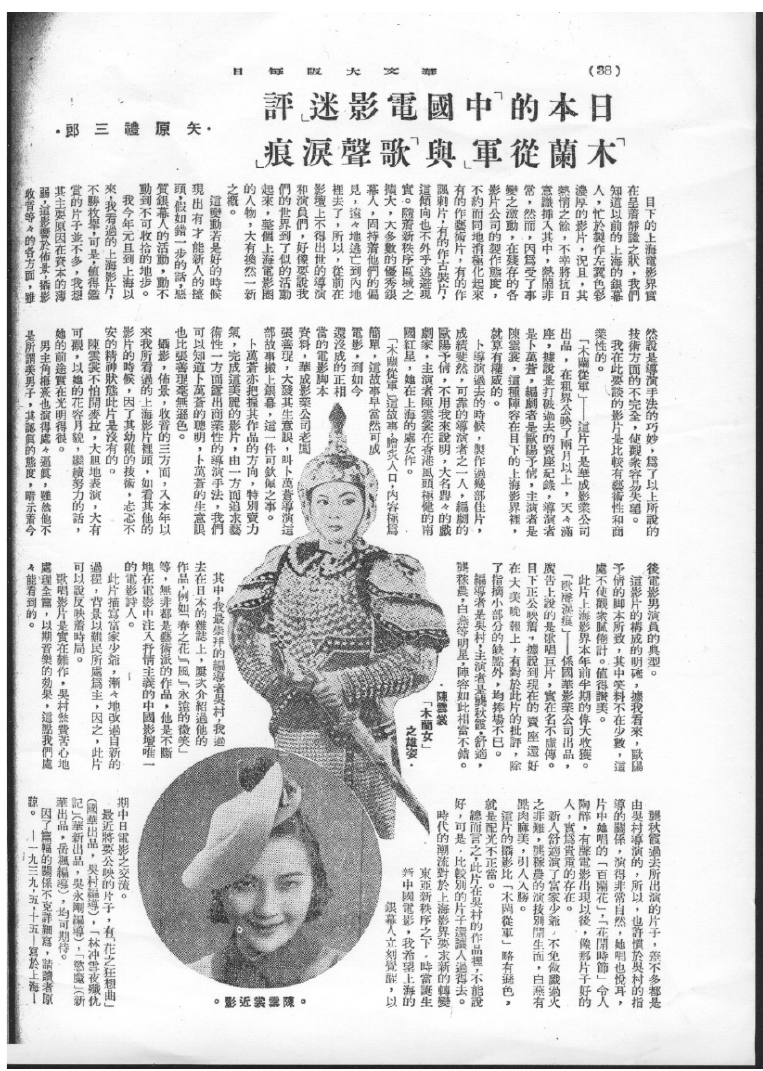
Figure 4. Yahara Reizaburou’s review of Mulan Joins the Army , published in Huawen daban meiri ( Osaka Daily in Chinese Language ) vol. 2, no. 11, 1939. Following the popular way at the time, illustrations for this article combine Mulan’s “mighty posture” (“ xiongzi ” in Chinese, literally “male posture”) in full armor with Chen’s feminine posture in modern dress.